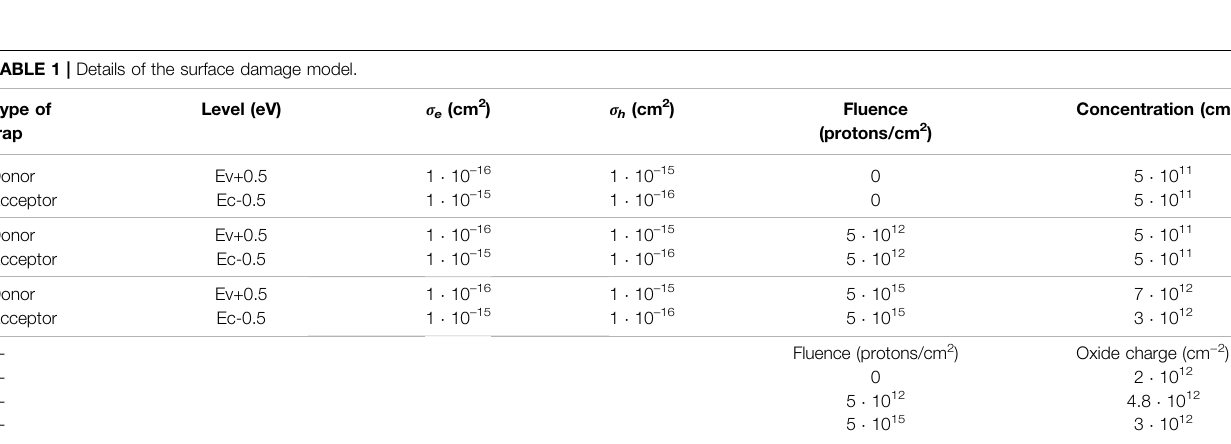
frequency, C-V curves for MOS capacitors were obtained at only 1 kHz. Therefore, the D it was found by fi tting simulated C-V curves to the measurement results. The interface states were modeled with two single trap levels, one donor at 0.50 eV from the valence band edge (E V ) and one acceptor at 0.50 eV